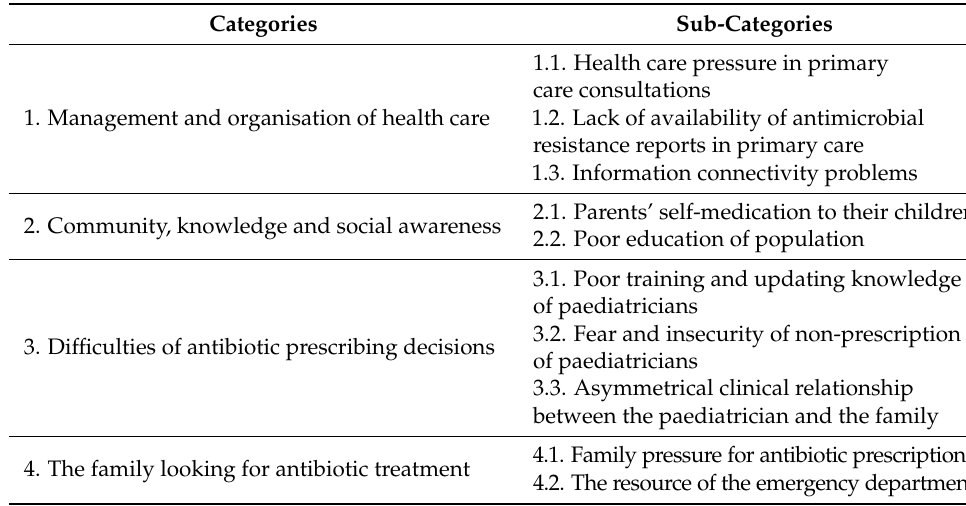
Table 2. Categories and sub-categories emerging from